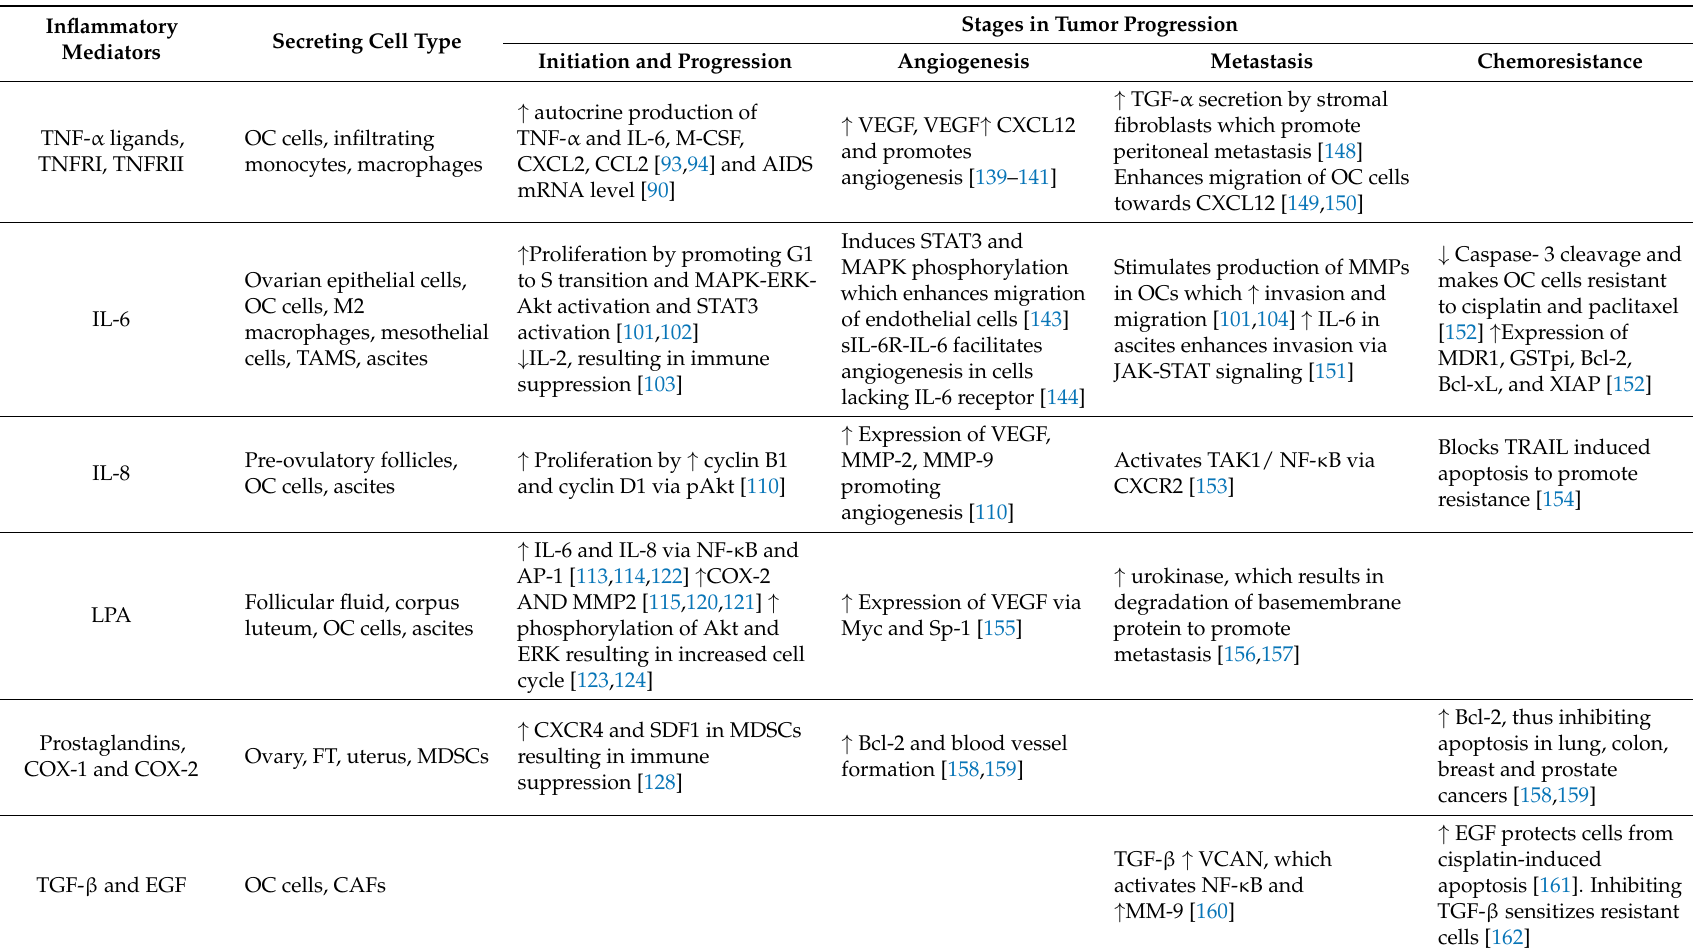
Table 1. Role of inflammatory mediators in different stages of tumor